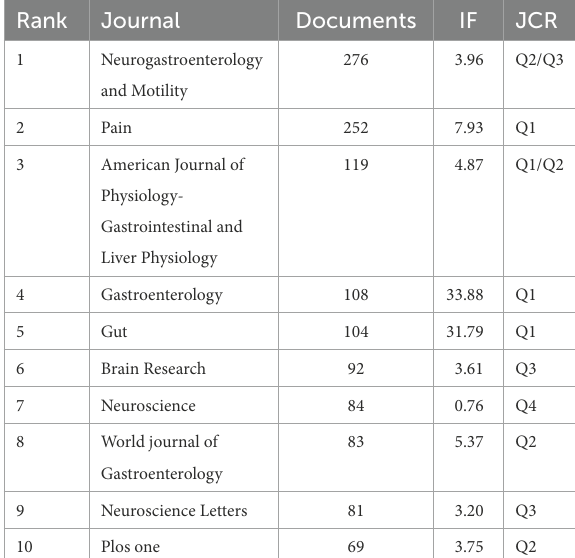
TABLE 4 The top 10 productive